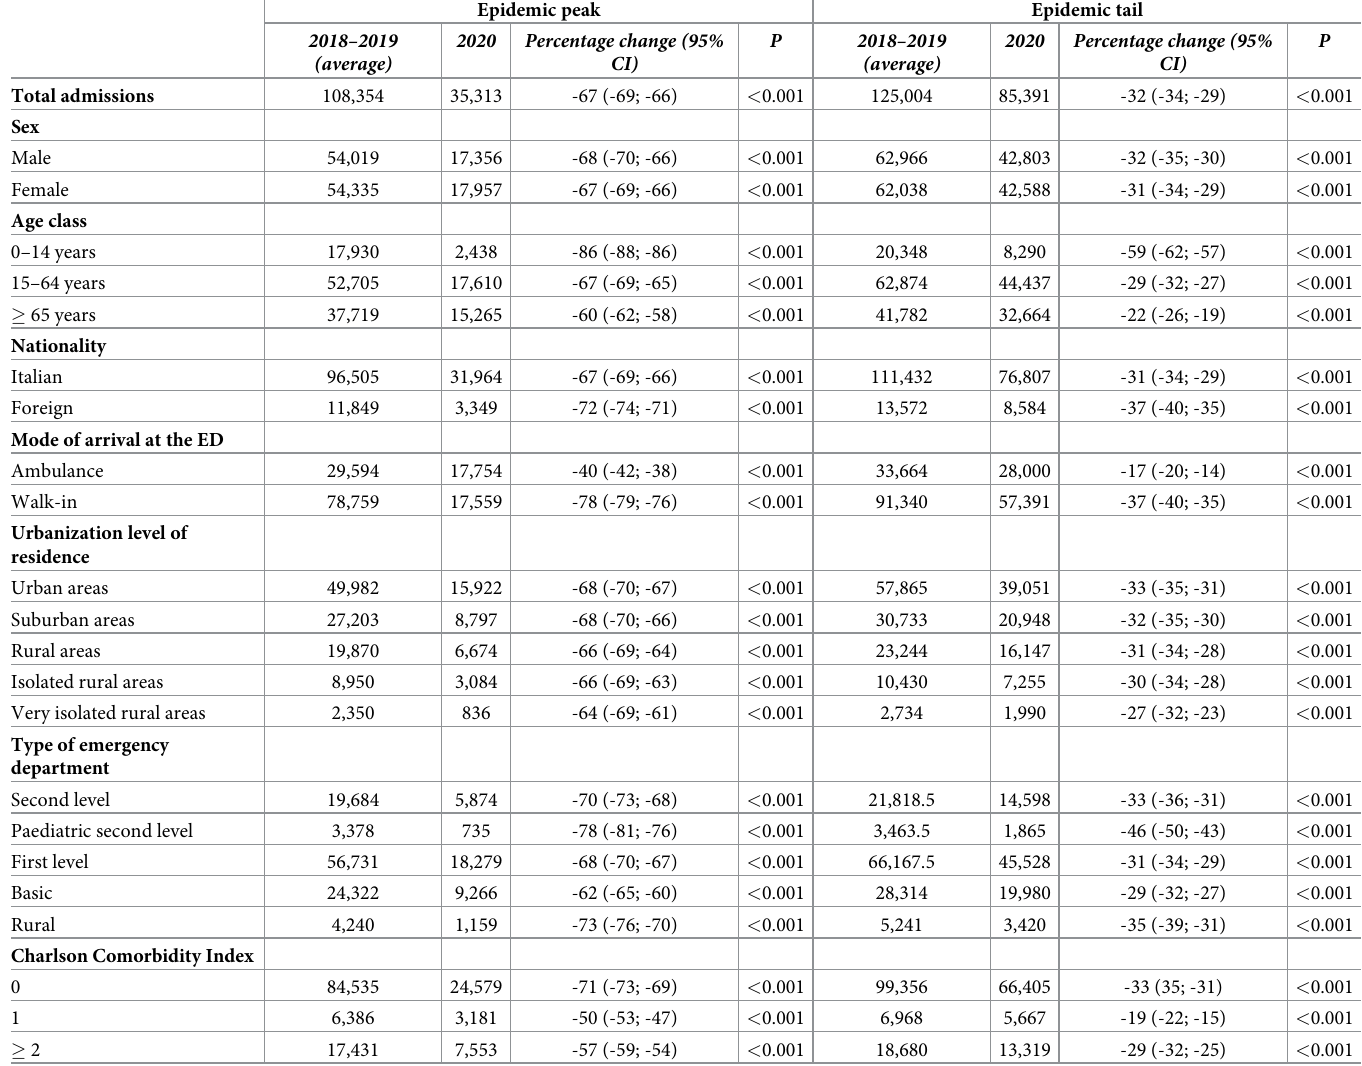
Table 1. Emergency department (ED) admissions in 2020 during the two considered epidemic periods (peak and tail) vs average ED admissions in 2018–19; per- centage changes and 95% CIs (Poisson regression